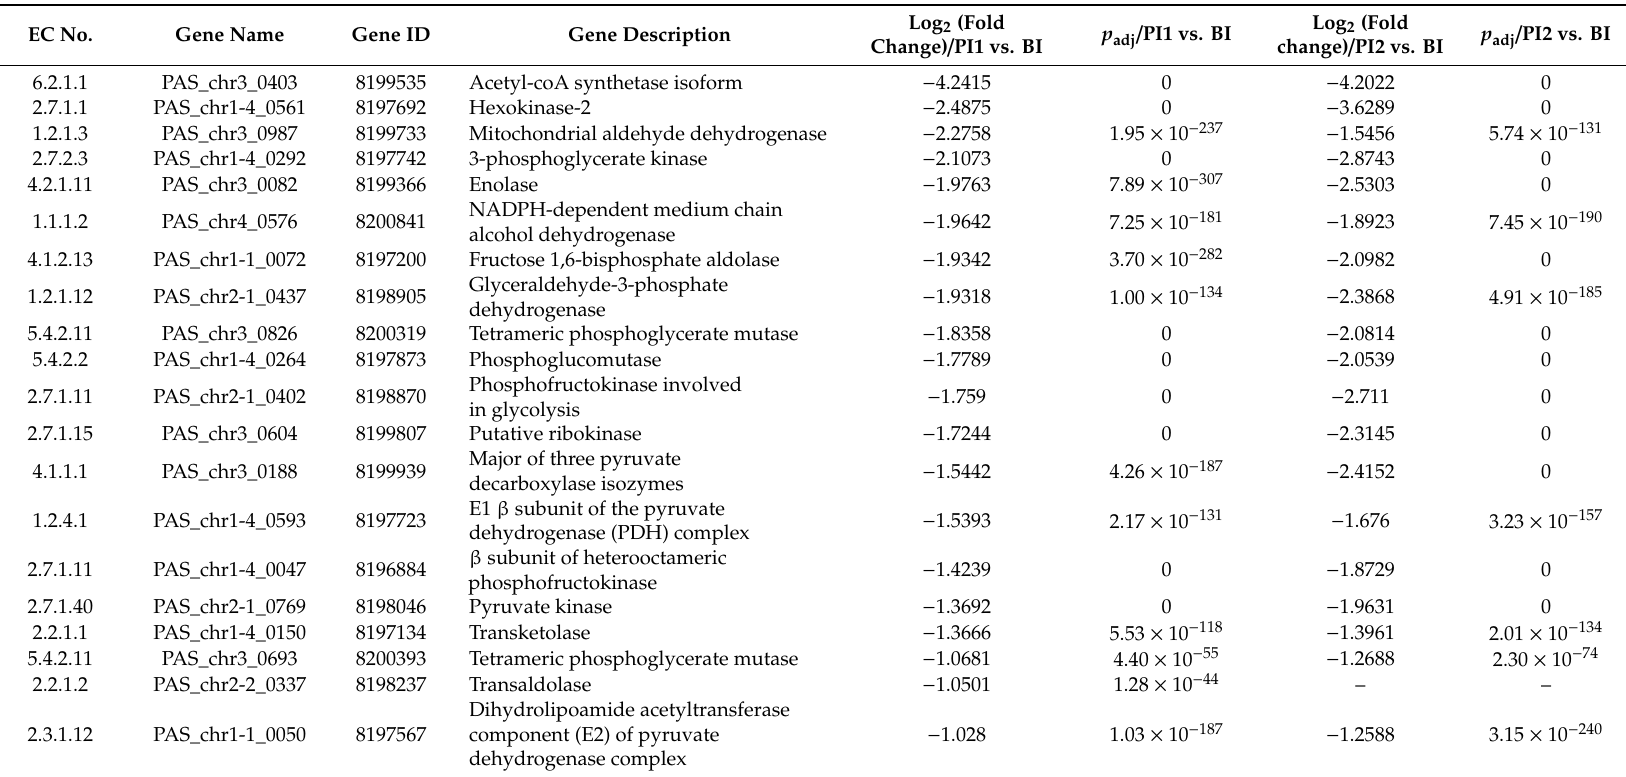
Table 1. Information of di ff erentially expressed genes (DEGs) involved in the central carbon metabolic pathway in PI1 and PI2 in comparison to BI. EC